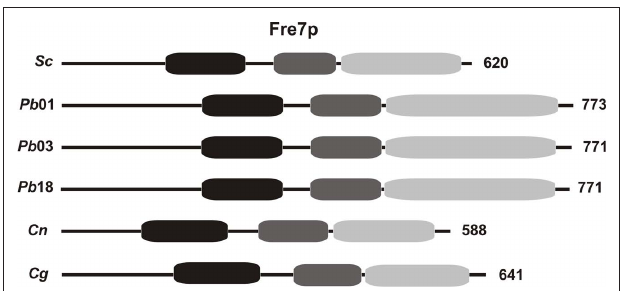
FiGure 2 | Domains found in a Frep related to iron reductive uptake in P. brasiliensis isolates and Cryptococcus species. The found domains are: ferric reductase domain (black boxes), FAD-binding domain (dark gray boxes) and NAD-binding domain (light gray boxes). The length of each protein, in amino acids, is shown on the right. Accession numbers: Sc (NP_014489), Pb 01 (PAAG_06164.1), Pb 03 (PABG_06497.1), Pb 18 (PADG_07957.1), Cn (CNAG_00876.2) and